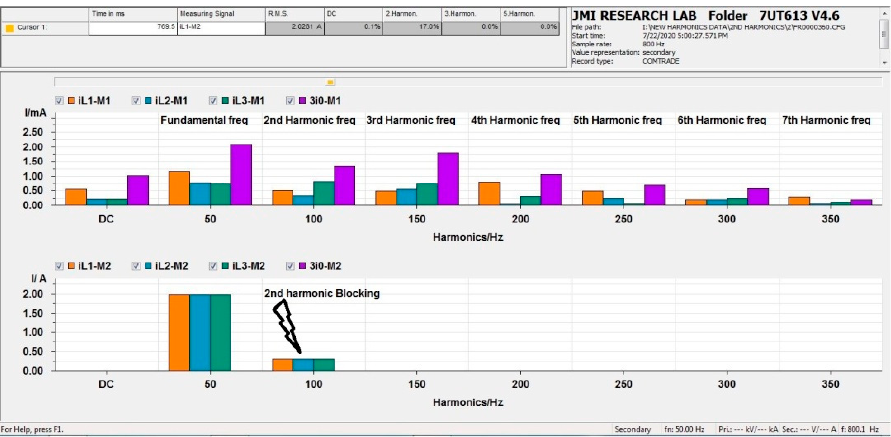
Figure 11. 2nd HB at 2000 mA Rated current & 15% of Inrush current condition.